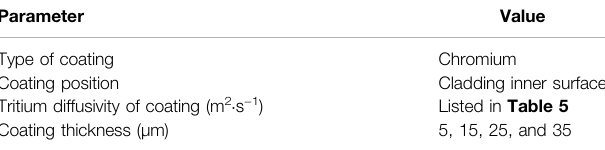
TABLE 3 | Simulation parameters of cladding with different coating